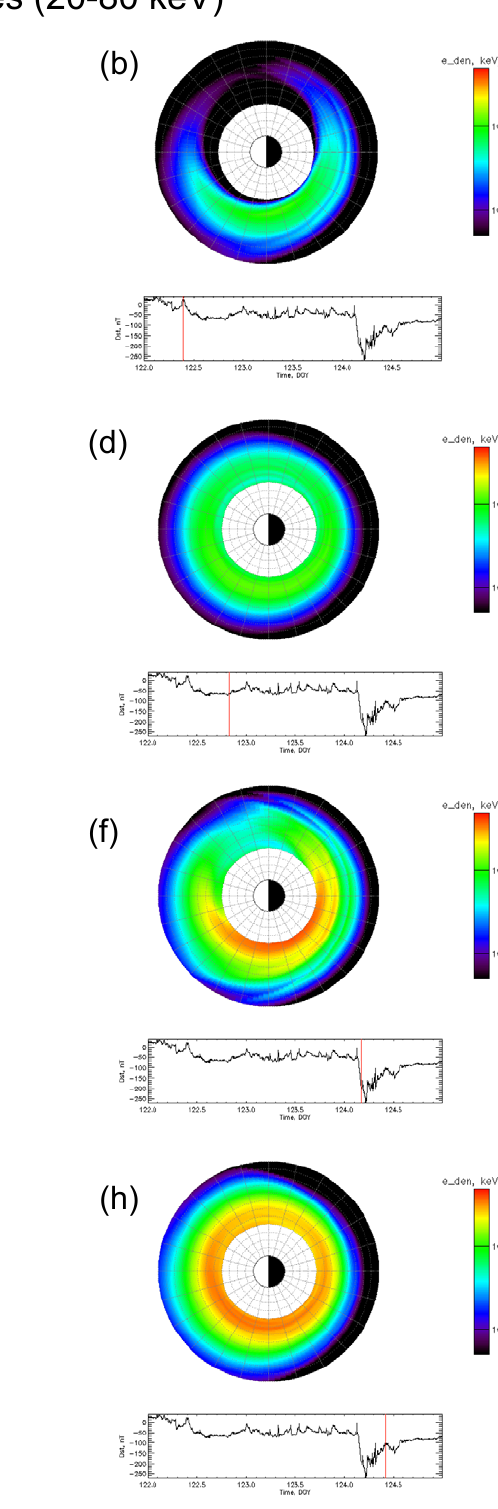
Fig. 8. Calculated energy density maps in the equatorial plane for protons with medium (20–80keV) energies when several electromagnetic pulses were activated at the substorm onsets during the modelled period of 2–4 May